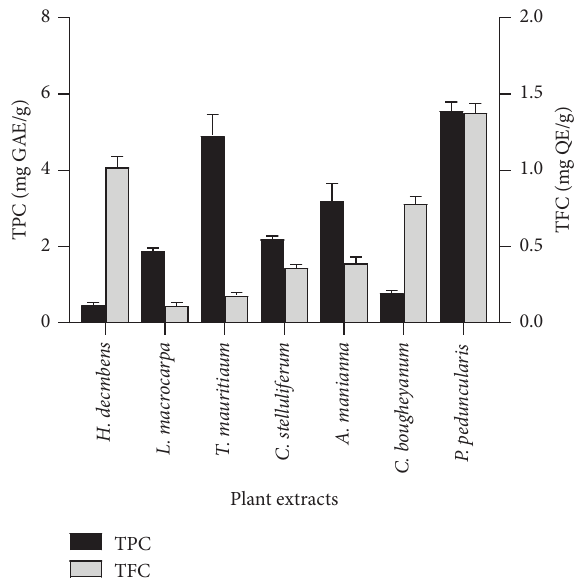
Figure 1: TPC and TFC of seven medicinal plant